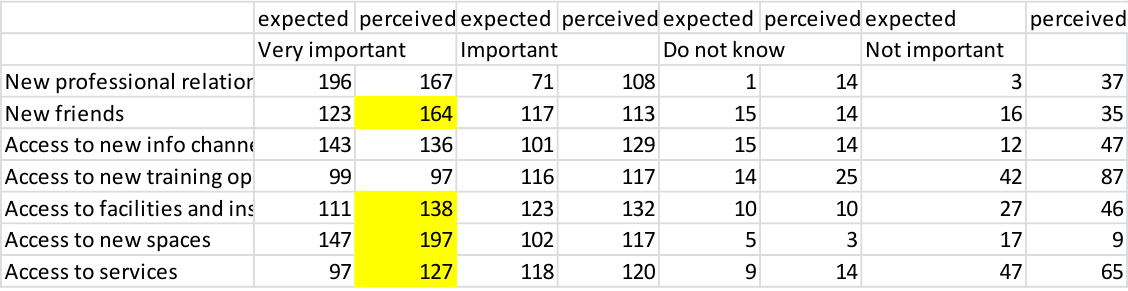
Table 1. The expected and perceived advantages to work in a CS Source: Akhavan & Mariotti,